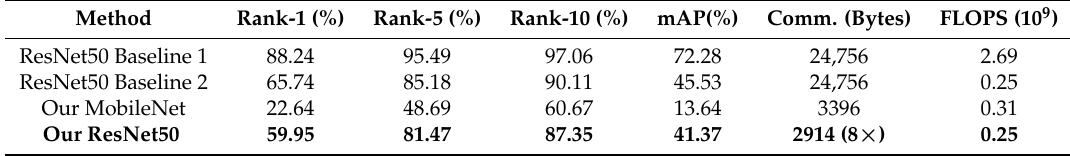
Table 7. Comparison with the baseline.